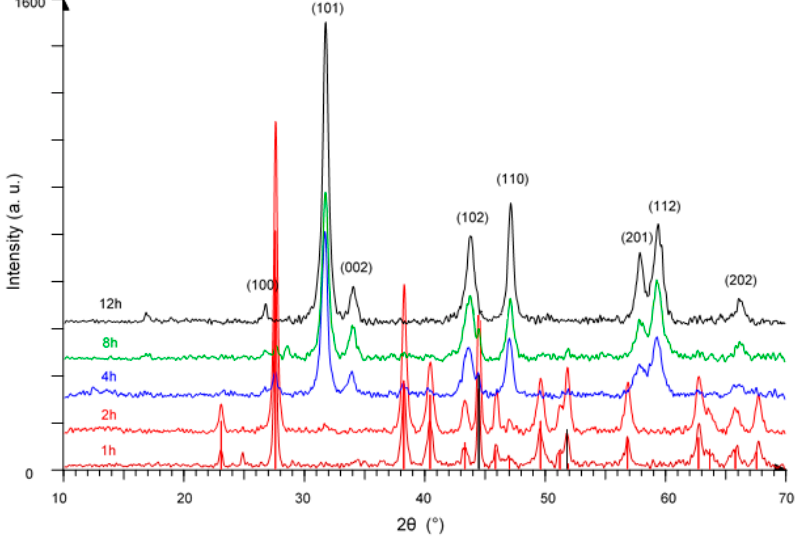
Figure 3. XRD patterns of Ni 2 Te 3 prepared mechanochemically after 1 h, 2 h, 4 h, 8 h, and 12 h milling time. Black and red vertical lines represent the precursors Ni and Te, respectively.